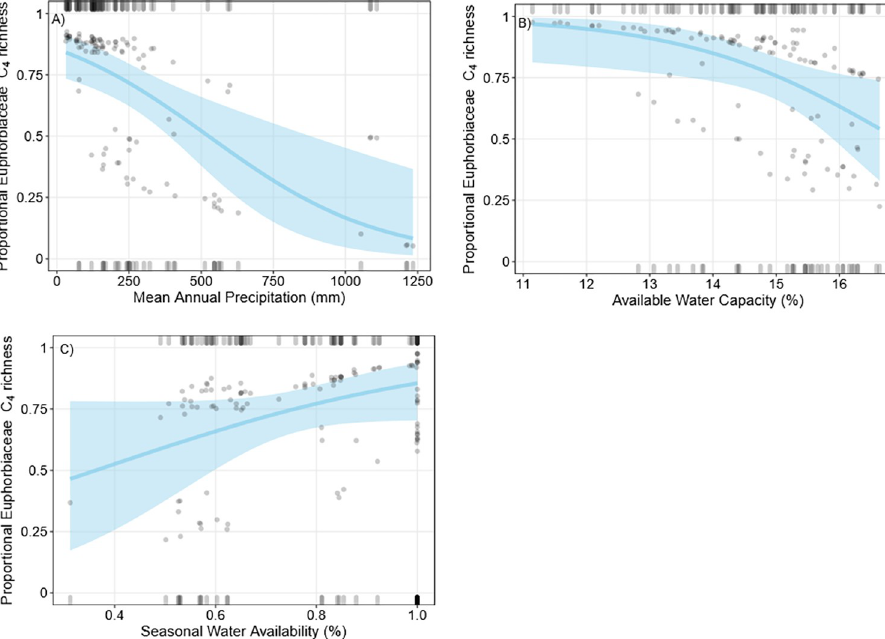
Fig 8. Binomial logistic regressions of proportional C 4 Euphorbiaceae richness. Grey points are partial residuals, blue lines and shaded bands are predicted outcomes of the regression and 95% confidence intervals respectively, and rugs were drawn to indicate observations with positive residuals (top of the plot) or negative residuals (bottom of the plot). For each plot, independent variables not depicted on the x-axis were held constant at their median value.